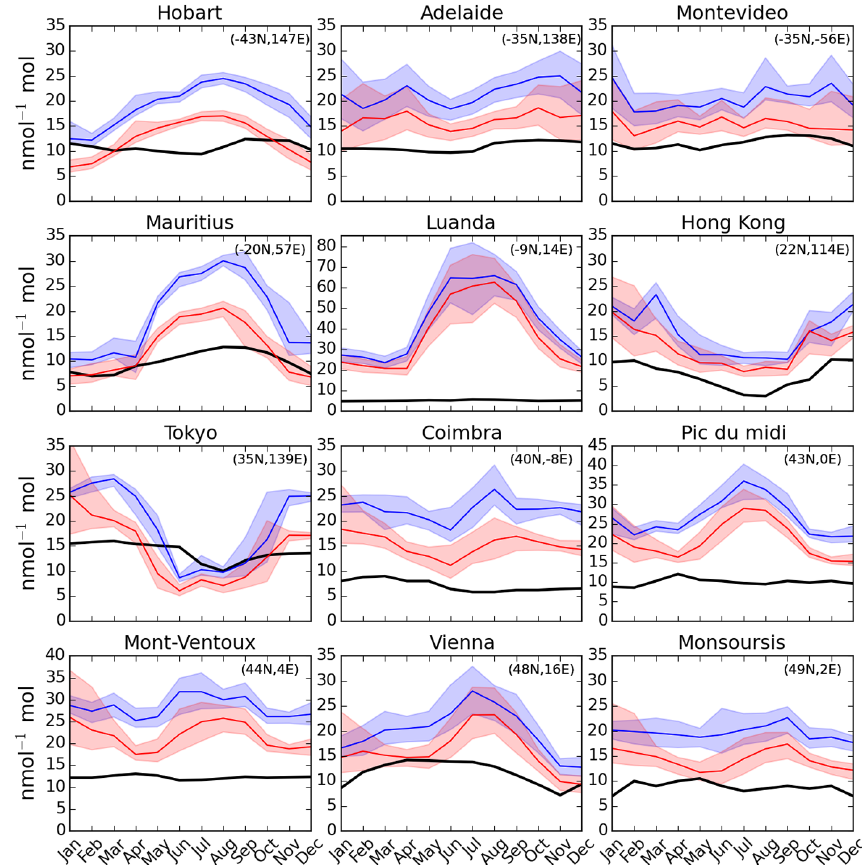
Figure 5. Comparison between observed and modelled preindustrial monthly mean O 3 . Observations are shown in black; preindustrial model simulation with halogens are in red and without halogens are in blue. The shaded areas for the model simulation shows the first and third quartiles in the hourly values. The O 3 data are reproduced (Mickley et al., 2001) from previously reported observations: Mont Ventoux, Hong Kong, Tokyo, Adelaide, Coimbra, Hobart, Luanda, Mauritius, Vienna, and Montevideo (Marenco et al., 1994); Pic du Midi (Pavelin et al., 1999); Montsouris (Volz and Kley, 1988).